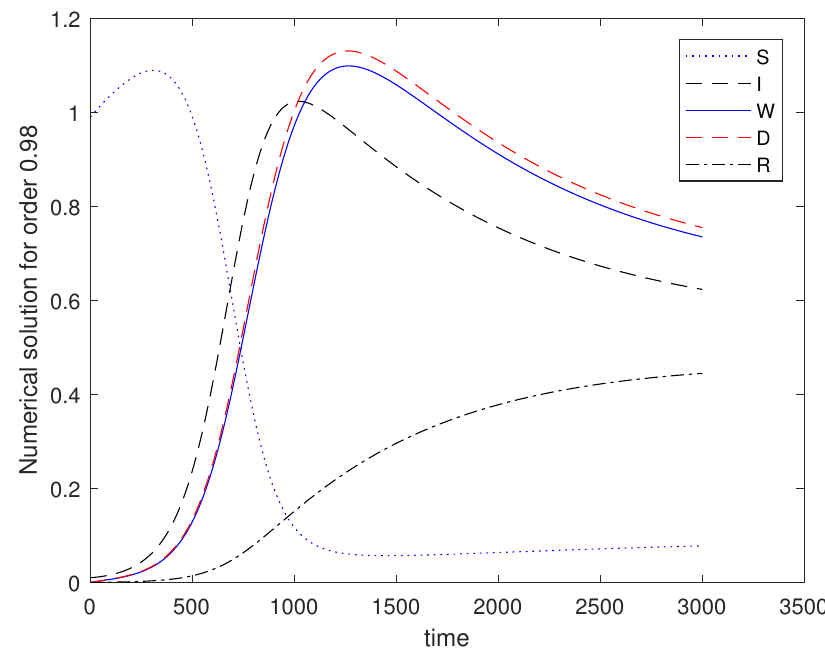
Figure 3. Numerical solution of the mathematical model for fractional order 0.98.